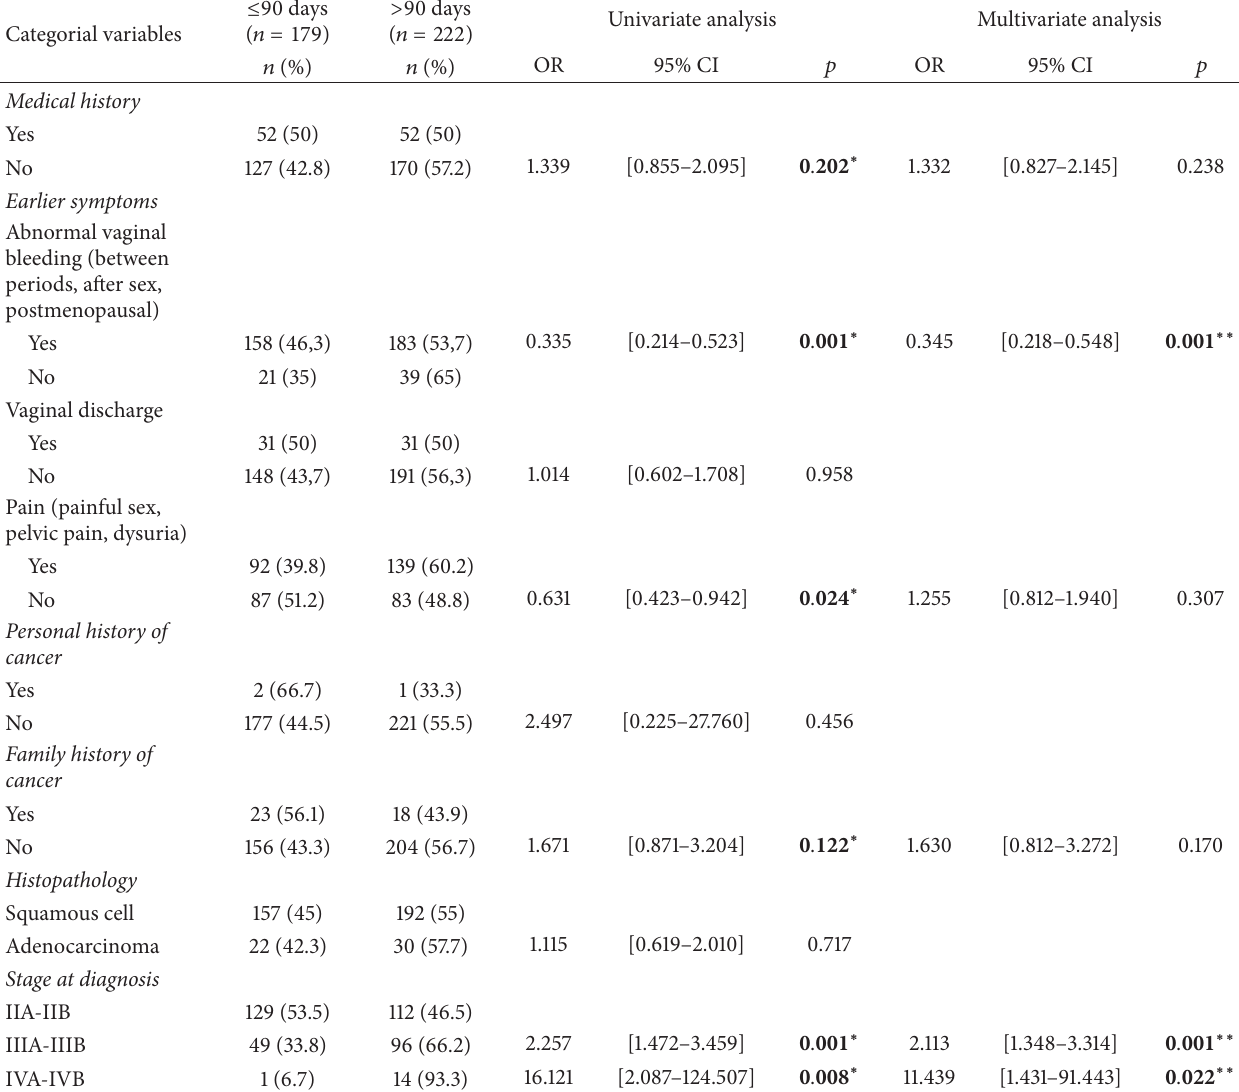
Table 4: Association between clinical factors and patient delay, identified by multivariate